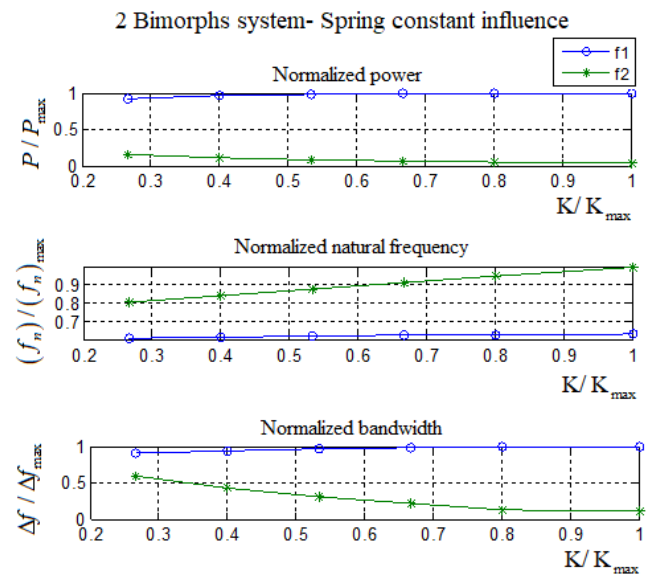
Figure A3. The influence of the normalized spring constant on the output power, the natural frequencies, and the bandwidth (all normalized)—two bimorphs interconnected by a spring case.